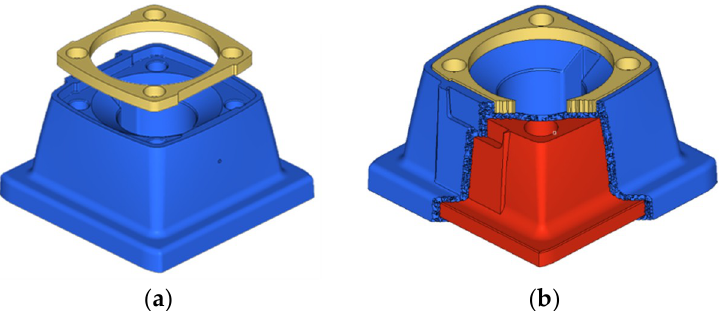
Figure 7. Case study part: Support (in blue) and membrane (in gold). ( a ) Support and membrane; ( b ) design domain (red) and non-design domain (blue).